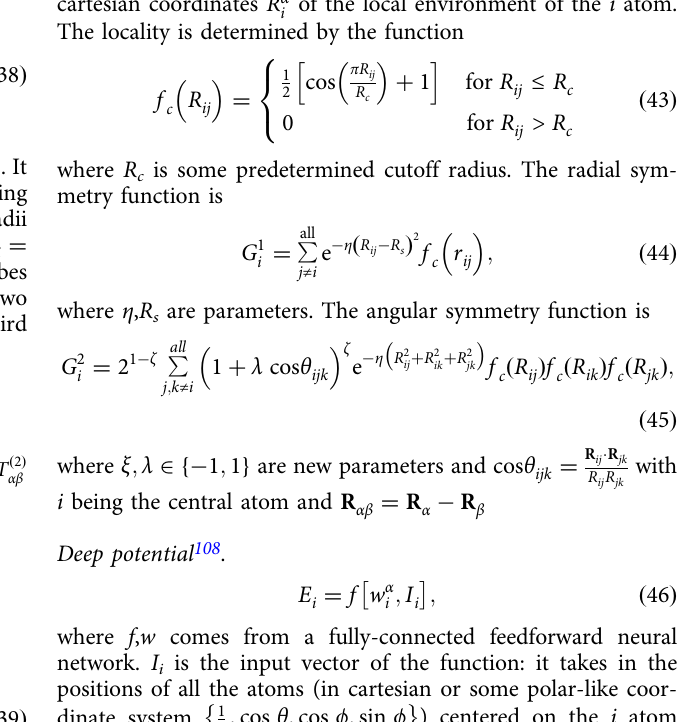
tangent for hidden layers and liner function for output.